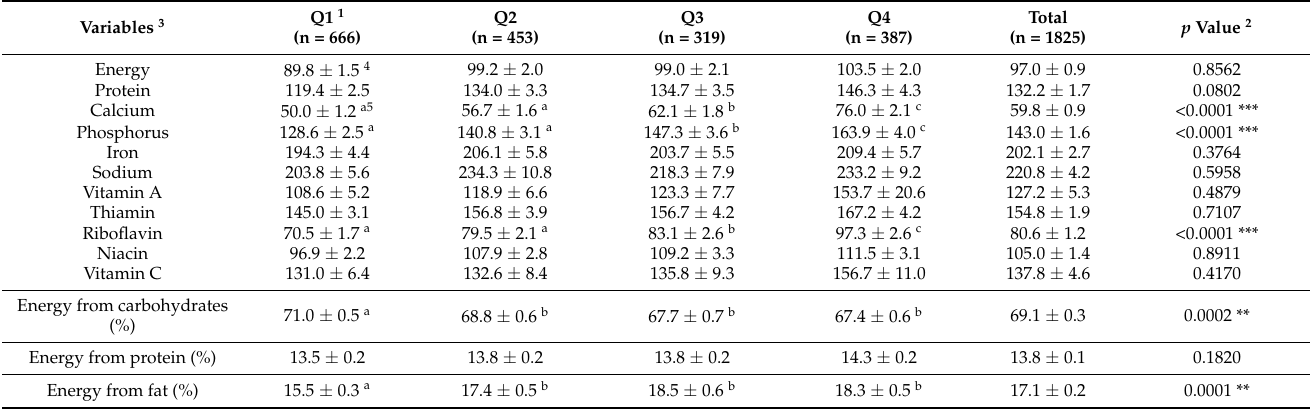
Table 2. The % KDRIs of nutrient intake according to cow’s milk intake